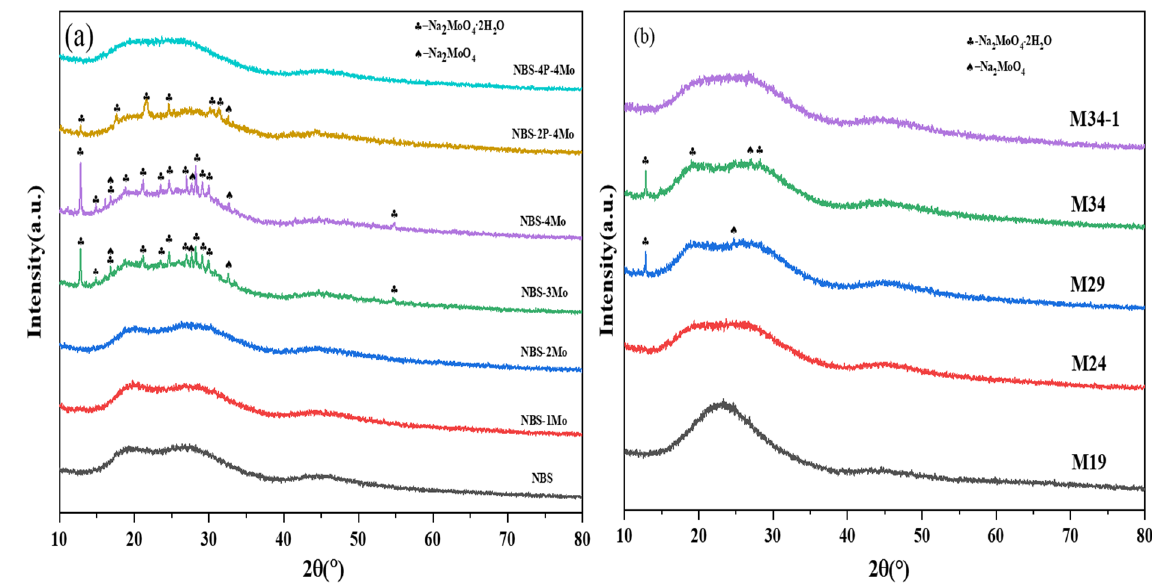
Figure 1. XRD patterns of ( a ) NBS-xMo and NBS-yP-4Mo series and ( b ) Mx series.